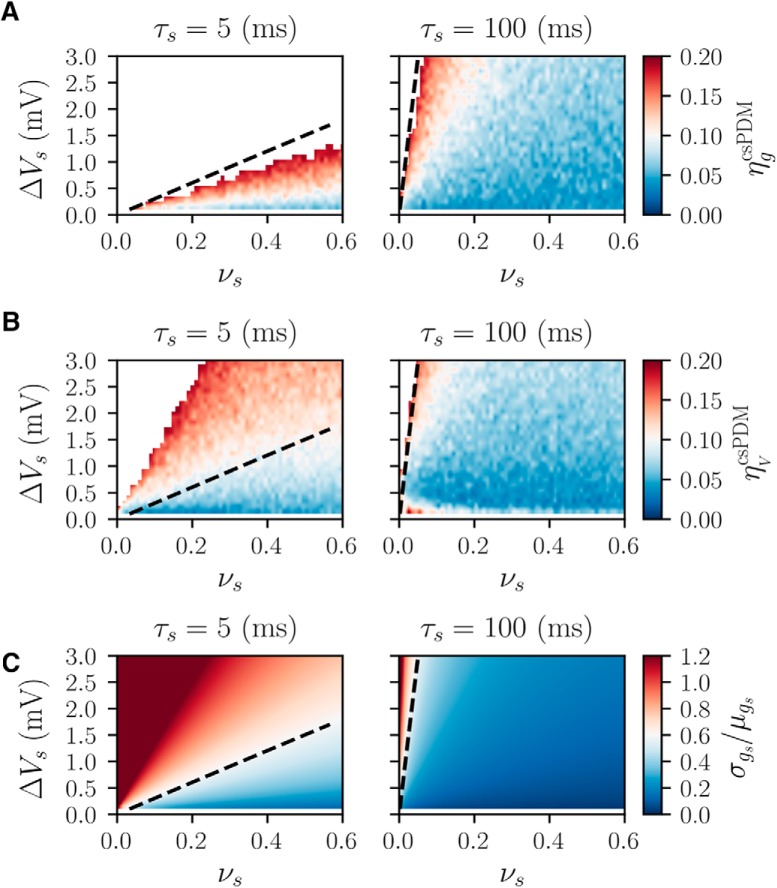

Steady-state values of ηgcsPDM, ηVcsPDM and σgs/μgs of a single population with respect to different νs and ΔVs
A, ηgcsPDM
B, ηVcsPDM
C, σgs/μgs. Black dashed lines indicate the sets of (νs, ΔVs) where σgs/μgs=0.6. Blank areas in A, B indicate the error ratio of >0.2.